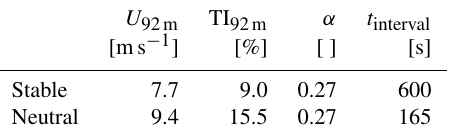
Table 6. Summary of the parameters of the measurement interval data used for the spectra of the blade and turbine loads: wind speed at hub height U 92m , turbulence intensity at hub height TI 92m , shear parameter α and the length of the available time interval t interval